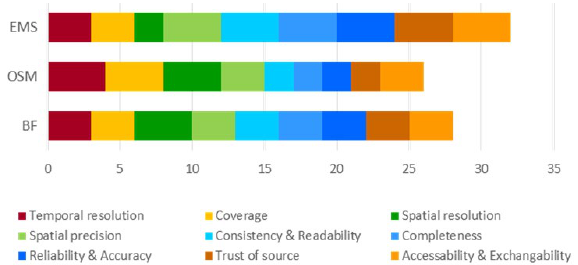
Figure 3 . Comparison of usability of freely available data sources of building footprints: European Settlement Map (ESM), Open Streetmap (OSM) and Building